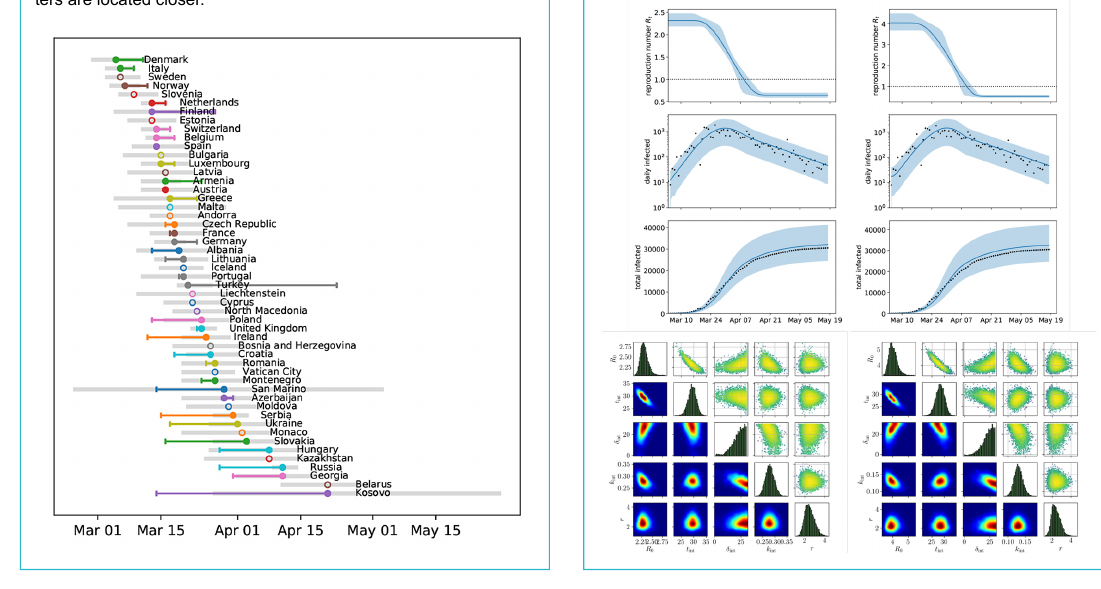
Figure 9: Inference with SIR (left) and SEIR (right) on data for Switzerland: predictions (top) and sampling (bottom). Inferred pa- rameters are R 0 , t int , δ int and k int . The incubation period in the SEIR model is 2.9